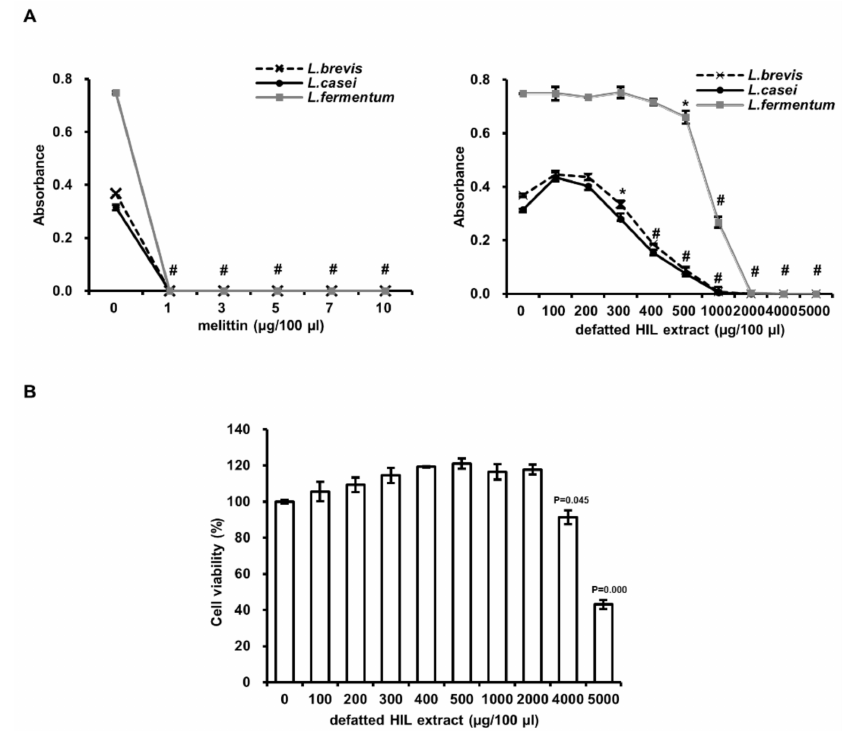
Figure 6. Antimicrobial activity of melittin and defatted HIL extracts against Lactobacillus species and cytotoxicity of defatted HIL extracts to Caco-2 human intestinal cells. ( A ) Determination of MIC of melittin and defatted HIL extract against three kinds of Lactobacillus species. Briefly, 1 × 10 6 cfu/mL of 90- µ L E. coli or S. aureus mixture was treated with various concentrations of 10- µ L melittin or defatted HIL extract dissolved in 0.05% acetic acid solution. Then, bacteria were grown for 24 h at 37 ◦ C. The experiments were independently performed in triplicate. A concentration of 0 µ g/100 µ L of melittin and defatted HIL extract indicates 0.05% acetic acid alone. The statistical analysis was performed by Student t -test. The significant differences were determined by comparing the absorbance of each experimental group with the control (0 µ g/100 µ L). Each value represents the means ± standard deviations of absorbance. * and # indicate p < 0.05 and p < 0.0001, respectively. ( B ) Analysis of the cytotoxic activity of defatted HIL extract. A total of 1 × 10 4 cells/well were treated with various concentrations of defatted HIL extract dissolved in 0.05% acetic acid solution after 24 h cell attachment and then further cultured in 5% CO 2 atmosphere for 24 h at 37 ◦ C. The experiments were independently performed in triplicate. A concentration of 0 µ g/100 µ L of defatted HIL extract indicates 0.05% acetic acid alone. Bar values represent the means ± standard deviations of relative